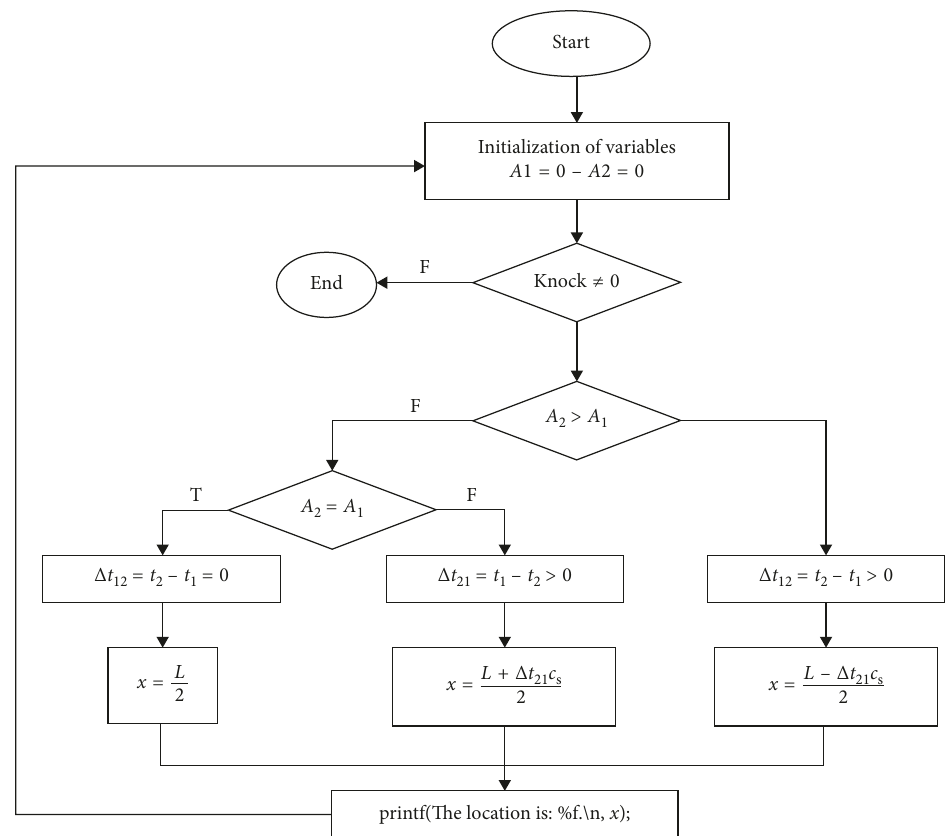
Figure 3: Flow diagram of the implemented program.